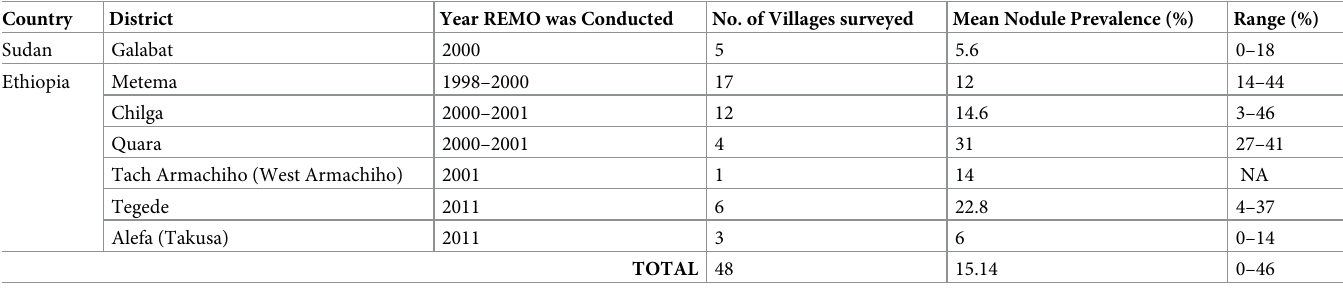
Table 1. Rapid Epidemiological Mapping for Onchocerciasis (REMO) conducted in Galabat and Metema between 1998 to 2011. Country District Year REMO was Conducted No. of Villages